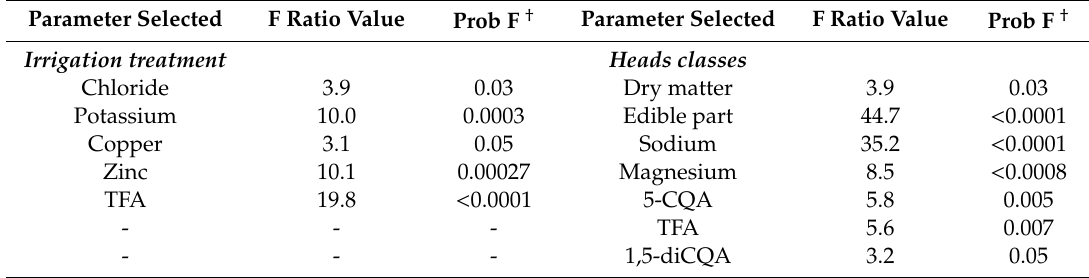
Table 5. Artichoke qualitative parameters selected by stepwise discriminant analysis applied to irrigation treatment and head